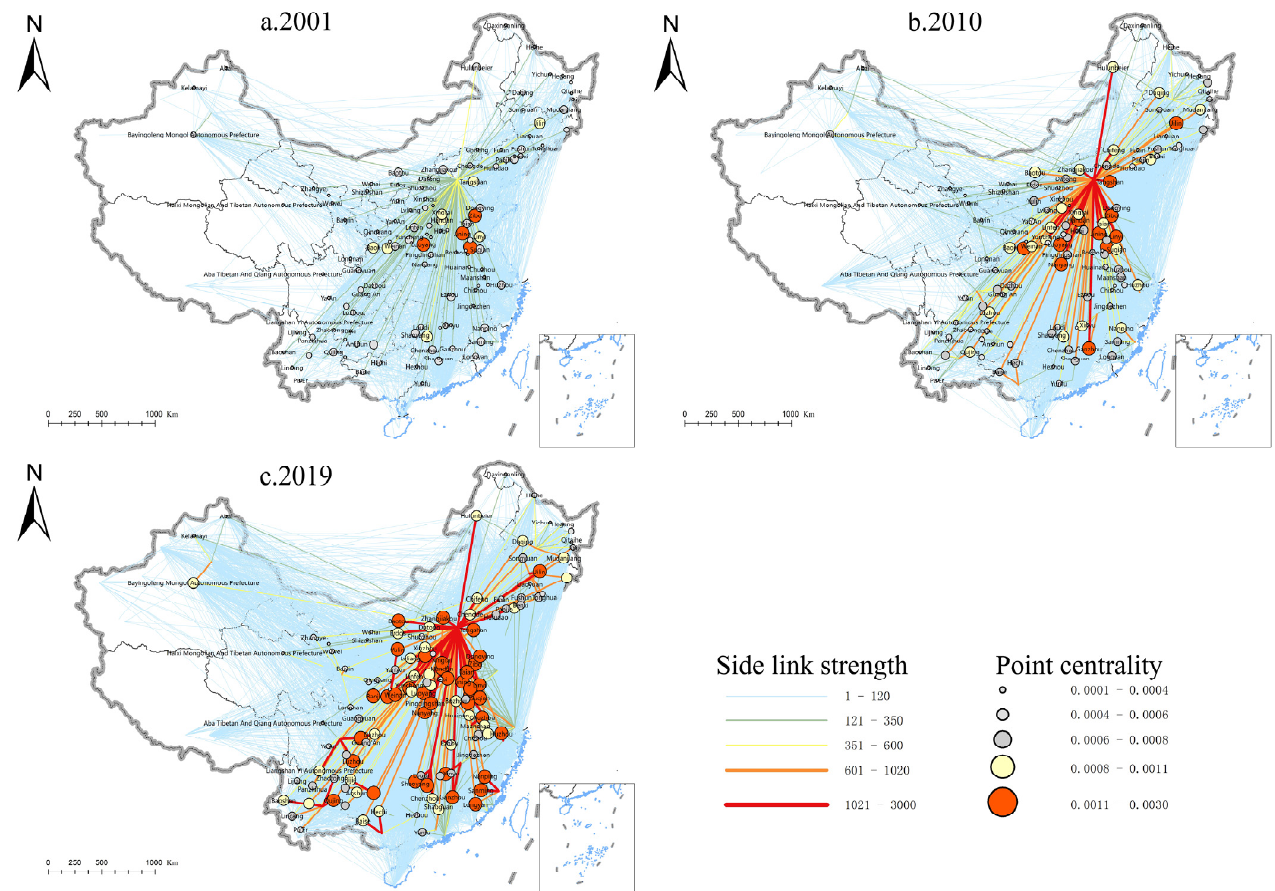
Figure 4. Characteristics of the spatial-temporal evolution of the proximity of organizational net- works.